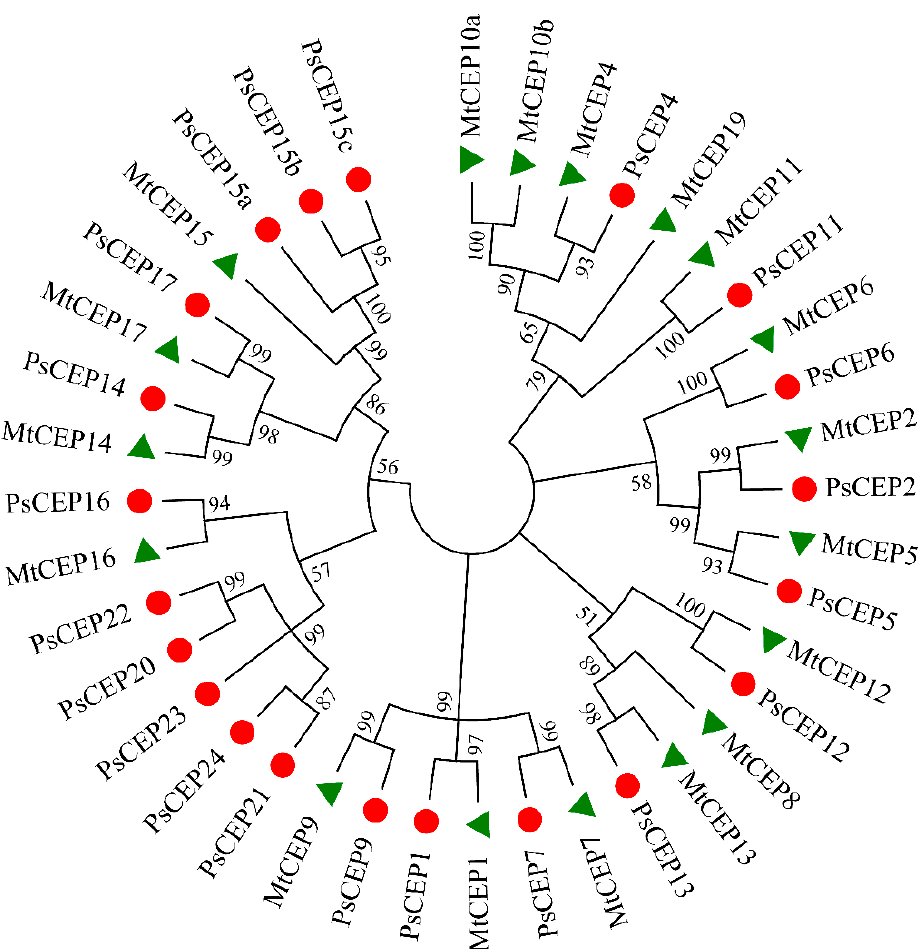
Figure 1. Phylogenetic tree built based on amino acid sequences of the PsCEP and MtCEP proteins. PsCEPs are marked with red circles, MtCEPs are marked with green triangles.